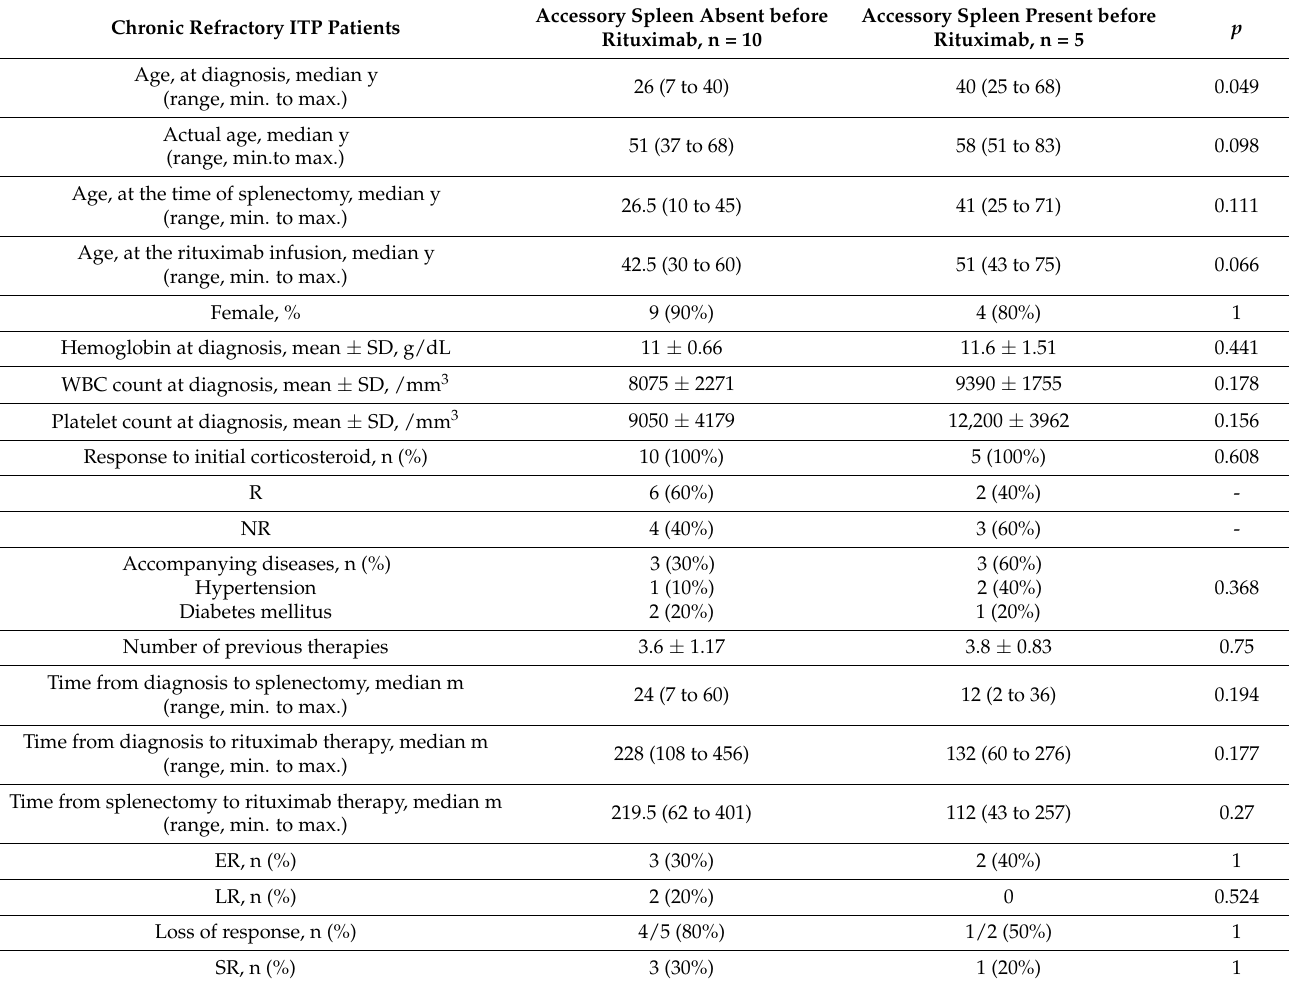
Table 1. Characteristic features of 15 patients with chronic refractory ITP according to the presence of accessory spleen prior to rituximab